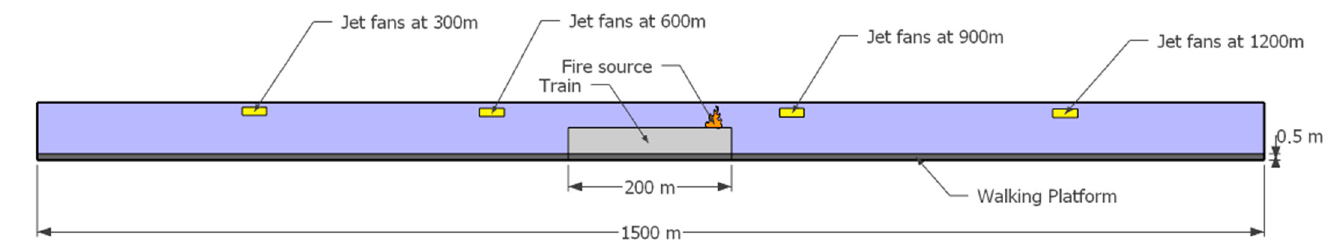
Figure 1. Side sketch of the tunnel with dimensions, the jet fans’ placement along the tunnel at positions x = 300, 600, 900, and 1200 m, and the walking platform.